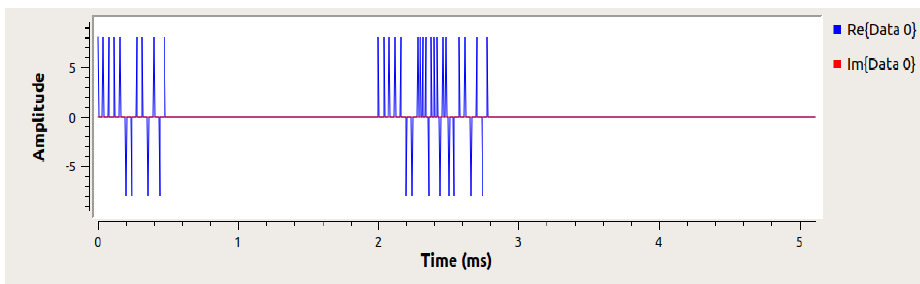
Fig. 4. Shape of the OFDM signal with BPSK at the receiver input (direct signal and 2 delayed